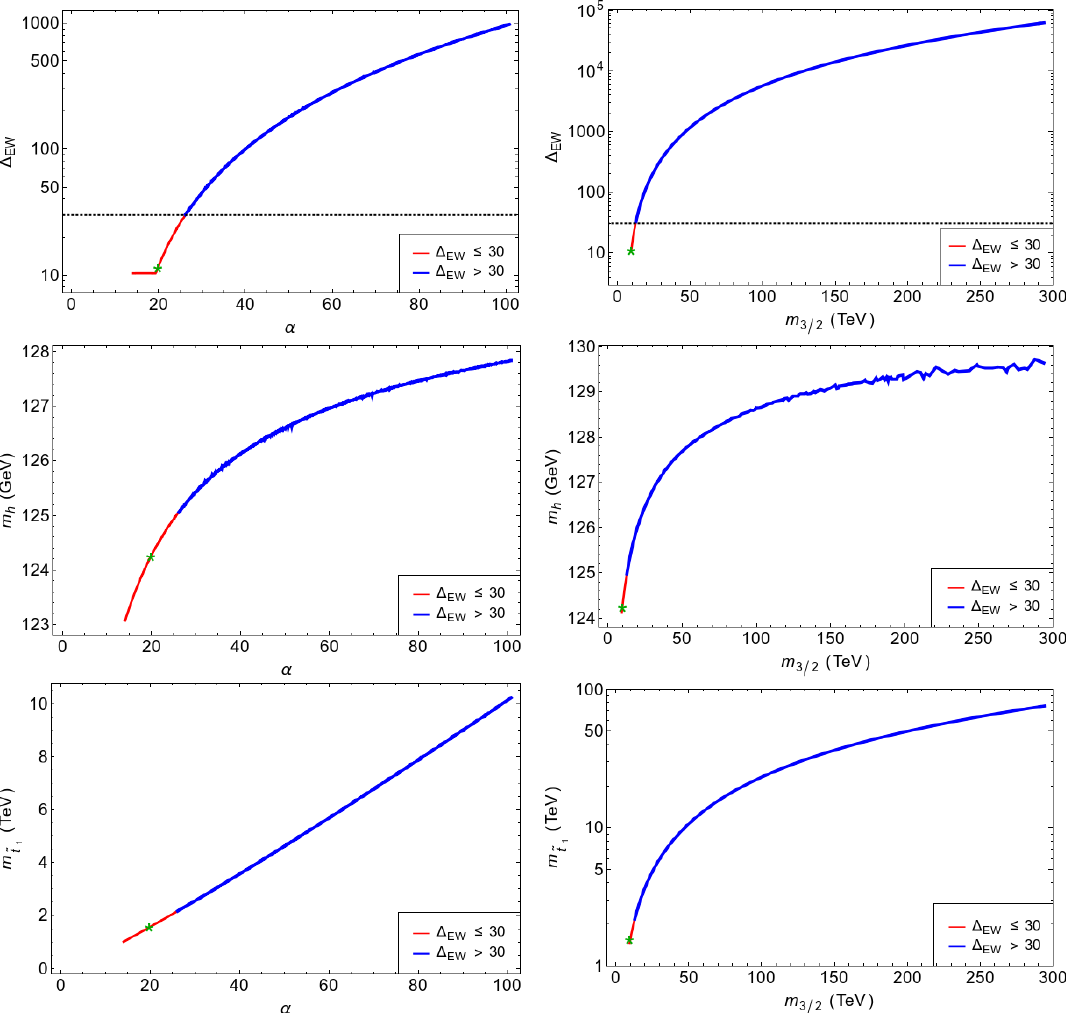
Figure 2 . (cid:1) EW , m h and m ~ vs. variation in (cid:11) and m for the mini1 benchmark point. The red 3 = 2 t 1 portion of the curves has (cid:1) EW < 30. The green star denotes the mini1 benchmark